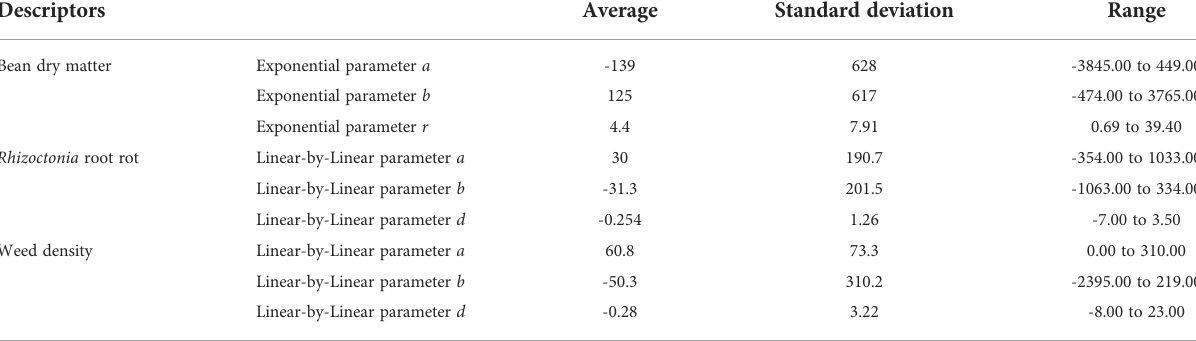
TABLE 2 Average, standard deviation, and range values obtained for metric variables of bean dry matter, Rhizoctonia root rot incidence, and weed density development in bean cultivars grown under different planting dates and weed control